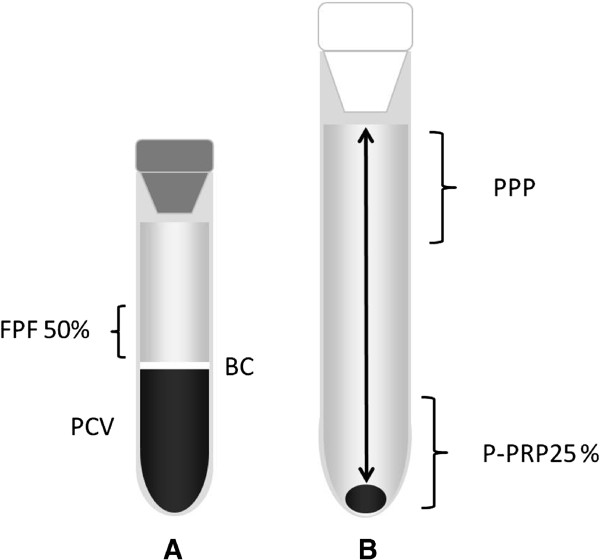
Graphic illustrating the plasma fractions obtained from the tube-method protocol. Left tube (A) contains the first plasma fraction (50%) (FPF) obtained by the single centrifugation tube method. Right tube (B) contains pure-platelet rich plasma (P-PRP) and platelet poor plasma (PPP). BC: Buffy coat. PCV: packed cell volume.